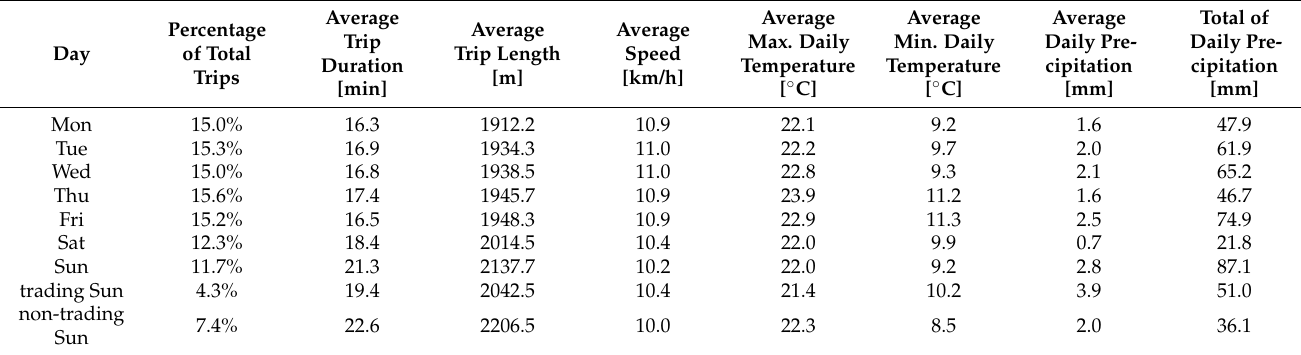
Table 3. Static characteristics of features of ŁPB trips and the selected weather conditions in Ł ó d´z by days of the week during the bike-sharing season of